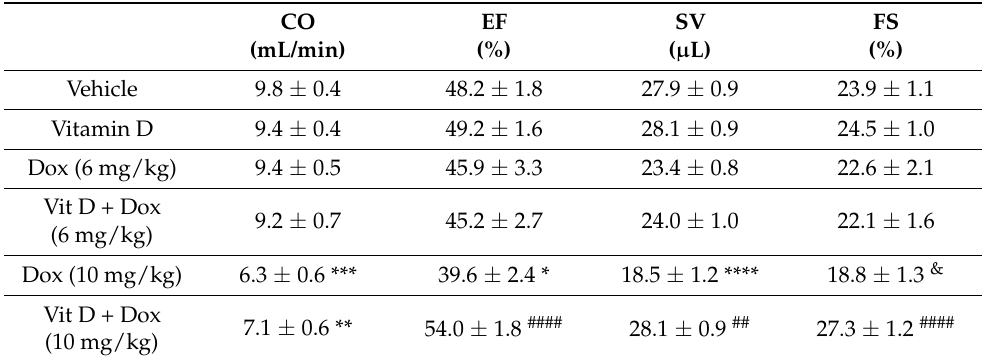
Table 1. Echocardiography